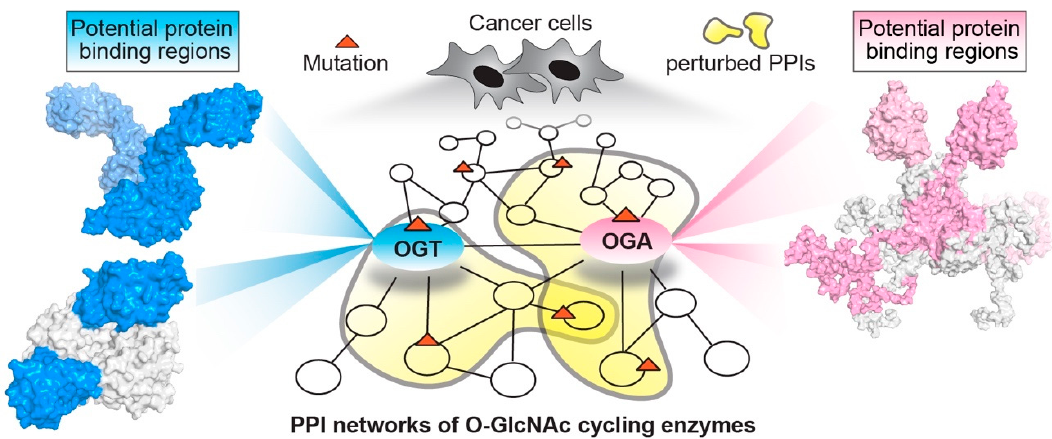
Figure 5. Integrating complementary approaches holds the promise of identifying key players (e.g., pathogenic mutations, altered pathways, or protein interactions) that drive cancer malignancies and will facilitate therapeutic innovations.